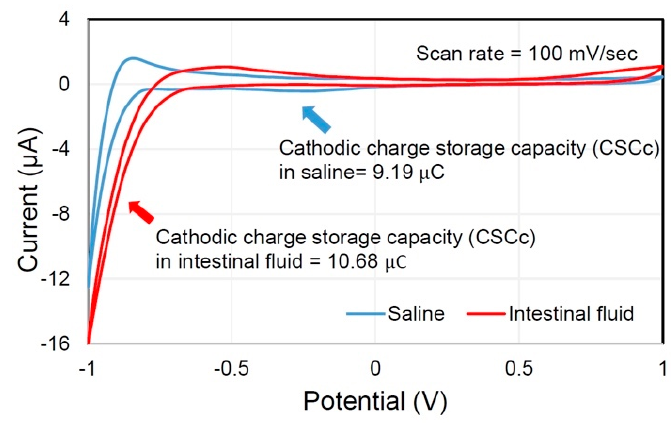
Figure 5. Measured cyclic voltammogram of electrode array in saline and intestinal fluid. Table 1. Summary of measured electrochemical properties of electrode–intestinal fluid and electrode–saline interface.